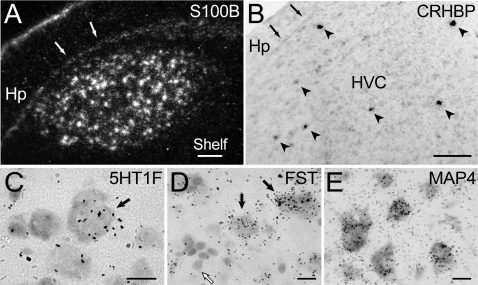
(A and B) Darkfield (A) and brightfield (B) views of nissl stained emulsion autoradiography depicting the expression of S100B (white signal) and CRHBP (black signal and arrowheads) in HVC, respectively; arrows delineate the ventricle. (D) High magnification bright-field views of emulsion autoradiography depicting examples of high expression (black grains) over the majority of large HVC cells (C; Arrows), a portion of these cells (D), or virtually all large and small cells (E) in sections hybridized with antisense probes directed against follistatin (FST), a serotonin receptor (5HT1F), and a microtubule associated protein 4 (MAP4), respectively. White arrow in C indicates an example of a non-labeled small cell. Scalebars: 100 µm in A and B; and 10 µm in C–E. See Fig. 2 legend for anatomical abbreviations.